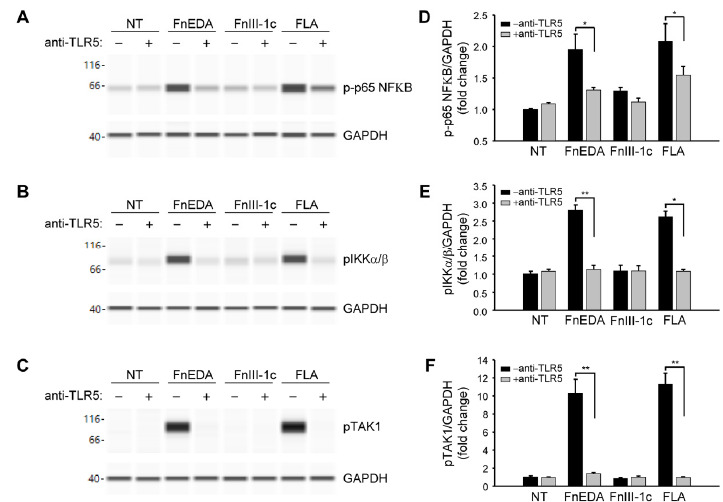
Figure 3. Activation of the NF κ B signaling pathway by FnEDA in MDA-MB-468 breast cancer cells is TLR5-dependent. MDA-MB-468 breast cancer cells were incubated with a TLR5 neutralizing antibody (anti-TLR5; 2 µg/mL) for 1 h prior to treatment with either FnEDA (5 µM), FnIII-1c (10 µM), or flagellin (FLA, 50 ng/mL) for 1 h. Cell layers were then rinsed and whole-cell lysates analyzed by WES. Representative Wes-ProteinSimple assay for ( A ) phosphorylated p65 NF κ B (p-p65 NF κ B), ( B ) phosphorylated IKK α / β (pIKK α / β ), and ( C ) phosphorylated TAK1 (pTAK1) are shown. Western analyses shown in ( A – C ) were quantified and normalized to GAPDH expression ( D – F , respectively). Data represent the mean ± SEM of three independent determinations. NT indicates no treatment. * p < 0.05; ** p < 0.01; Student’s t -test.